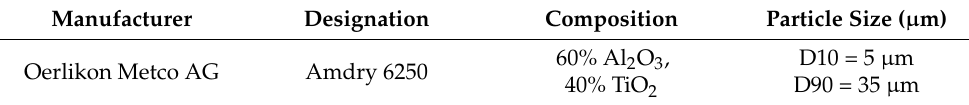
Table 3. Optimized spray plasma spray parameter set used in coating operation of the tube.